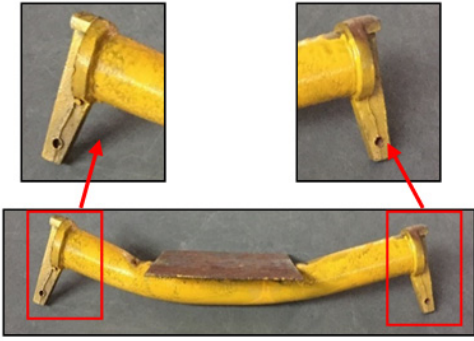
Figure 9. Bending failure mode of a horizontal bar.